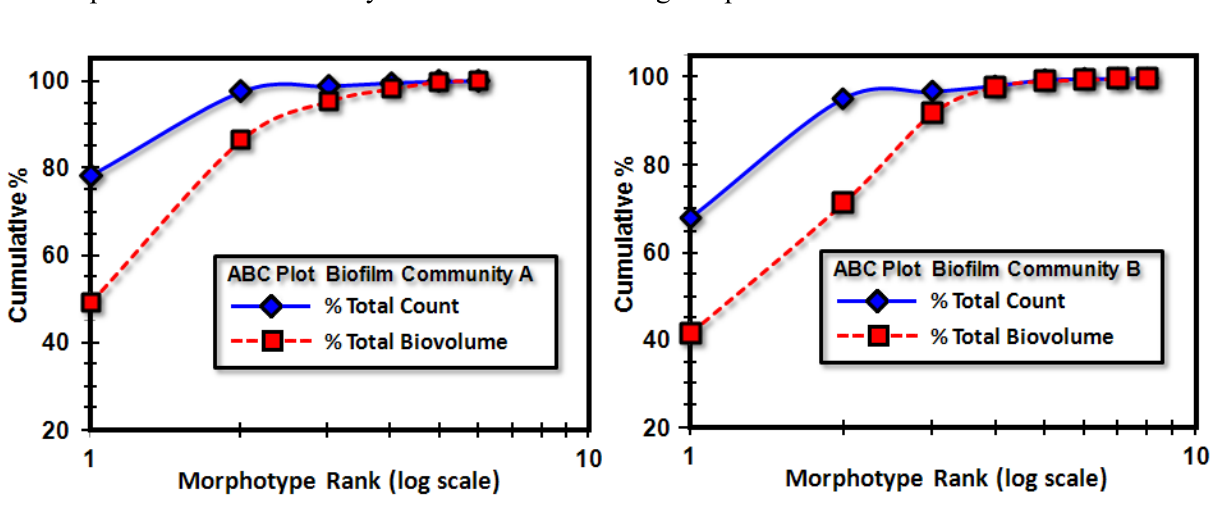
Figure 5. Abundance/biomass comparison (ABC) plots for community assemblage A ( a ) and B ( b ). Greater separation of the two curves implicates a more intense ecophysiological response of the community to environmental change or